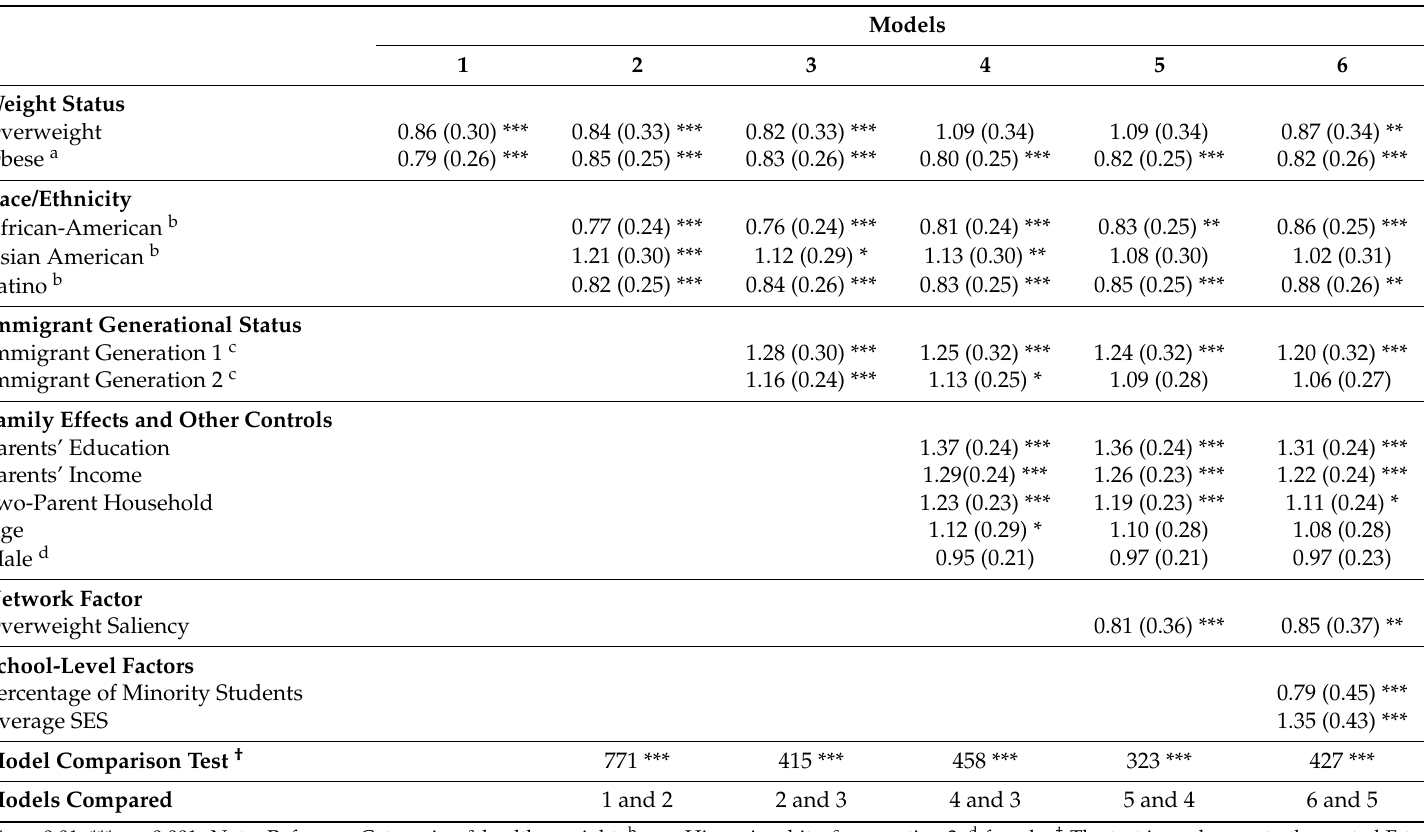
Table 4. Predictors of having a Bachelor’s degree or higher: odds ratios and their standard errors (in parenthesis).